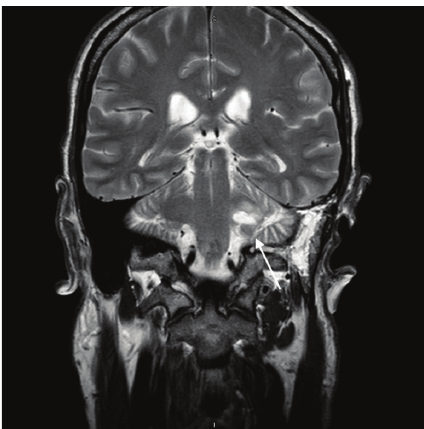
Figure 7: Coronal MR image (T2 weighted) showing the postoper- ative